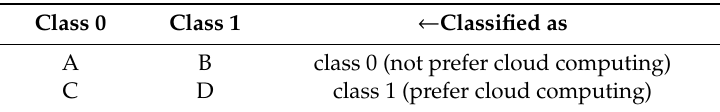
Table 3. Confusion